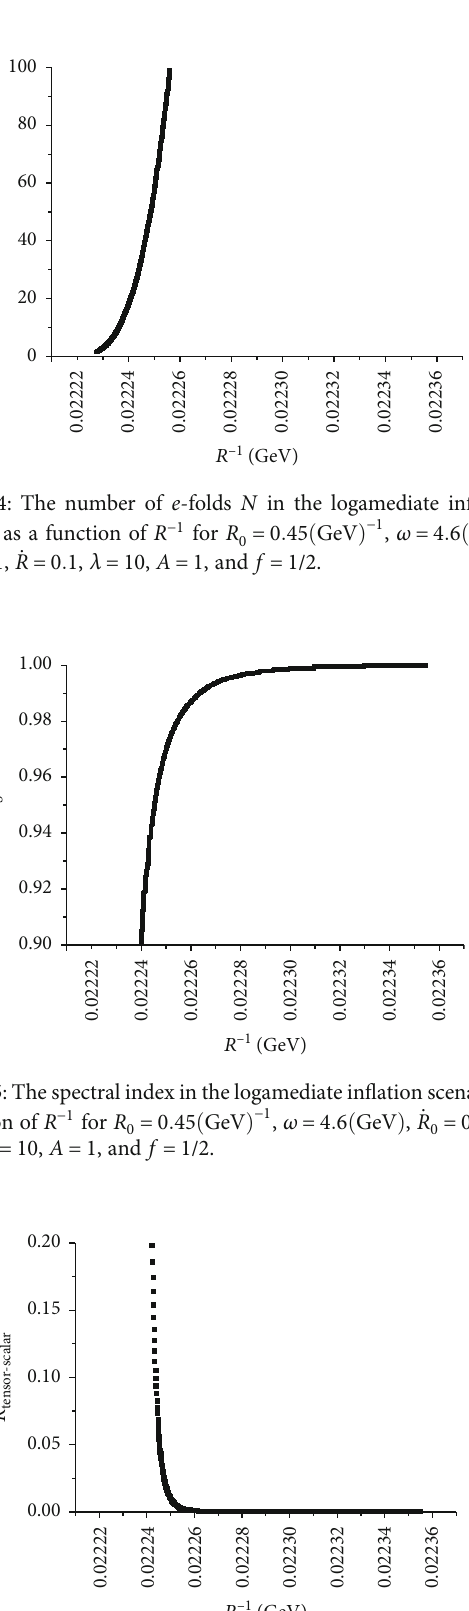
_ _ = 0 : 01 , R R = 0 Figure 6: The tensor-scalar ratio in the logamediate in fl ation scenario as a function of R − 1 for R _ _ = 0 : 01 , R = 0 : 1 , λ = 10 , A = 1 , and f = 1/2 . R 0